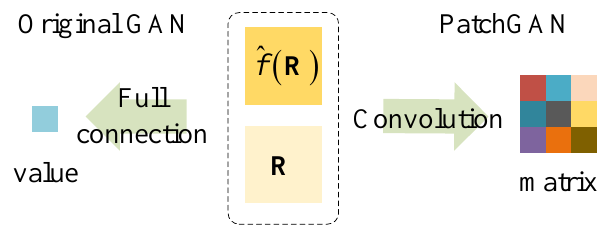
Figure 3. Comparison of original GAN and